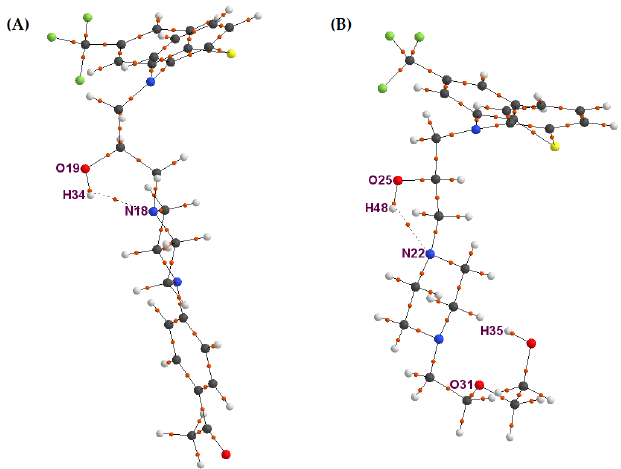
Figure 3. The molecular graphs for APh-FLU ( A ) and for HEE-FLU ( B ). The black straight lines and black dashed lines represent the bond paths between attractors. Attractors correspond to each atom’s position: carbon (black), hydrogen (white), nitrogen (blue), oxygen (red), and fluorine atoms (green). The orange smallest points represent the BCPs for the bond paths. These values meet the listed above criteria for all investigated TFMP derivatives and unambiguously show that these bond paths represent the covalent chemical bonds. The bond paths depicted by dashed lines can be observed in the gaseous phase for APh-FLU and HEE-FLU only. The value of electron density for the BCPs of the bond paths repre- sented by dashed lines, i.e., between H34 and N18 atoms for APh-FLU and between H48 and N22 atoms for HEE-FLU, was ρ BCP = 0.02037 and ρ BCP = 0.02164, respectively (Table 3).